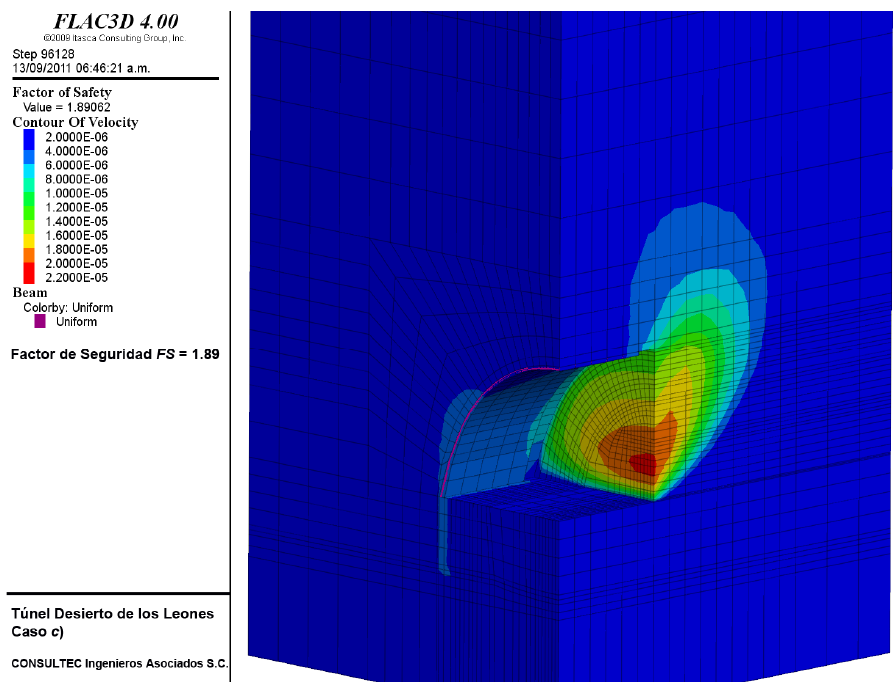
Figure 38. Potential mechanism of instability for case (c): excavation at maximum depth in the intermediate zone (Tobas and Pomez) with minimum parameters. Definition: Caso (c) (case c), Factor de Seguridad (safety factor).